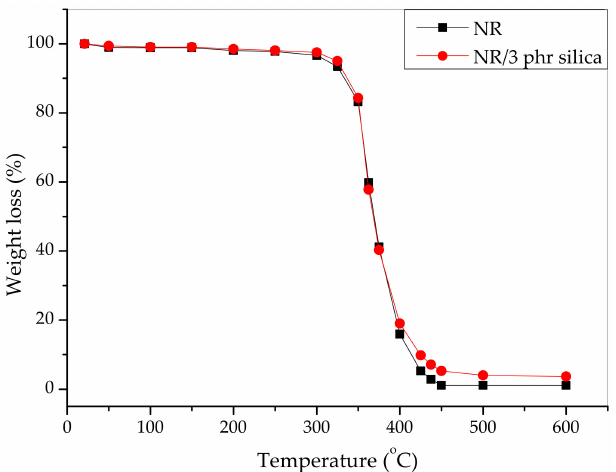
Figure 9. TGA of cured natural rubber (NR) (black dot line) and 3 phr of nanosilica filled natural rubber (red dot